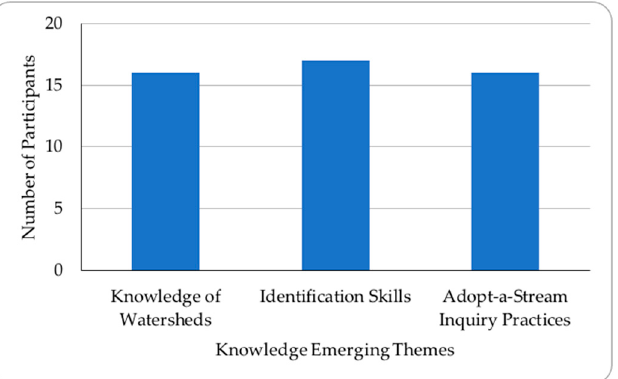
Figure 3. The frequency of emerging themes for the code knowledge.